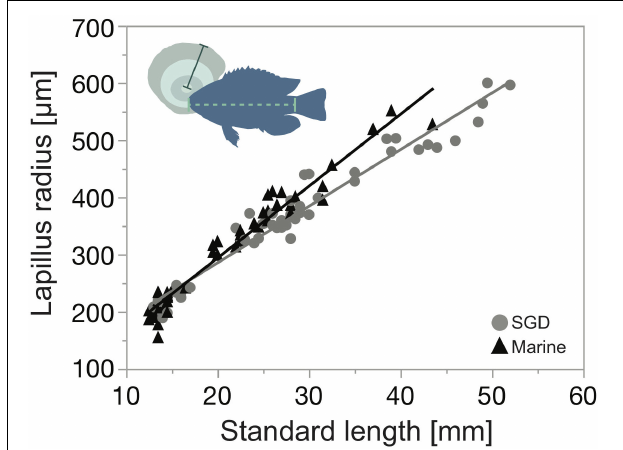
FIGURE 3 | Relationship between lapillus (green) radius (dark green solid line) and juvenile Chrysiptera glauca (blue silhouette) standard length (light green dashed line) inside a tide pool influenced by fresh submarine groundwater seepage (SGD, gray circles), and in a strictly marine tide pool (marine, black triangles).